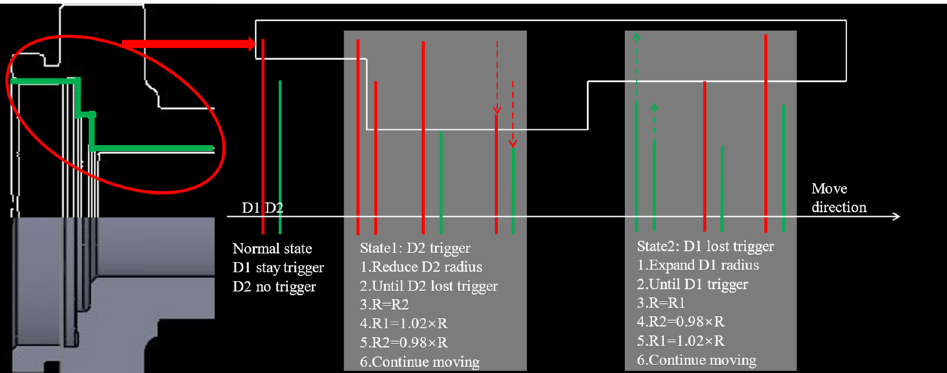
Figure 7. The mesh solid model and the detection sequence of the shifting fork.